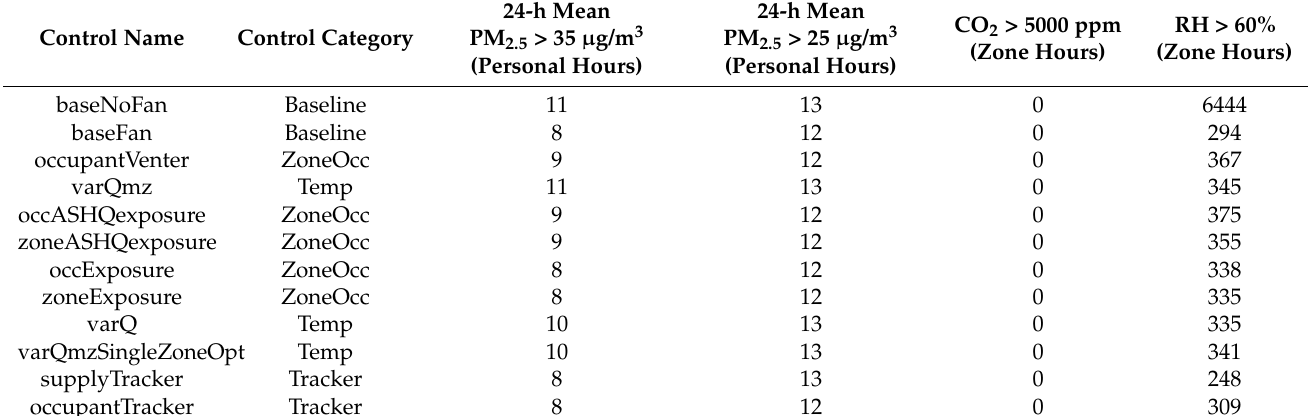
Table 4. Summary of median personal concentrations, personal concentration ratios, energy savings, and ventilation pa- rameters for each ventilation control type Table 5. Median sum of personal- or zone-hours exceeding regulatory or design thresholds for each control strategy, including PM 2.5 , CO 2 , and relative humidity. PM 2.5 limits are based on 24-h threshold values from the U.S. EPA (35 µ g/m 3 ) Variable and the World Health Organization (25 µ g/m 3 ). 5000 ppm CO2 is based on the OSHA Permissible Exposure Limit. 60% RH is a common design threshold for buildings.